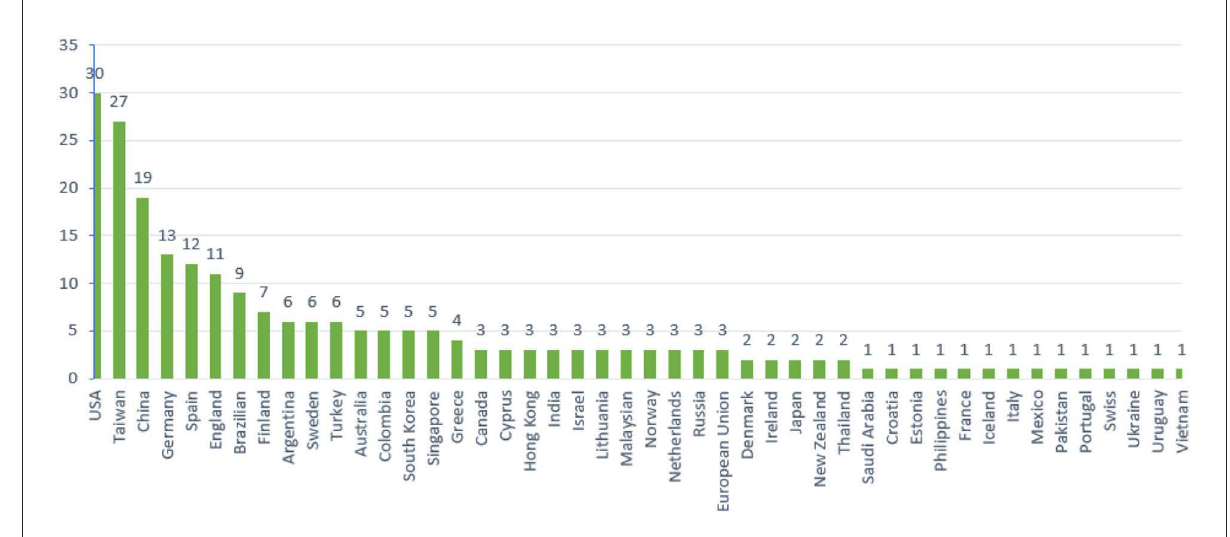
FIGURE2 Number of paper per